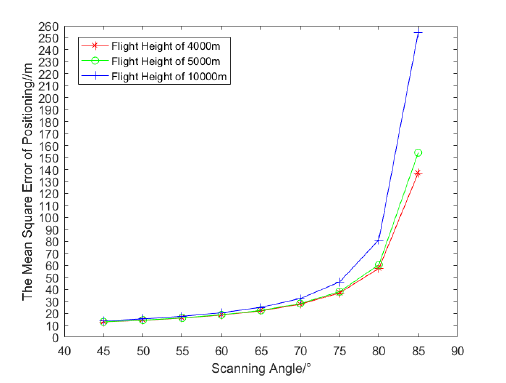
Figure 4 . The Plane Positioning MSE at Different Flight Height.